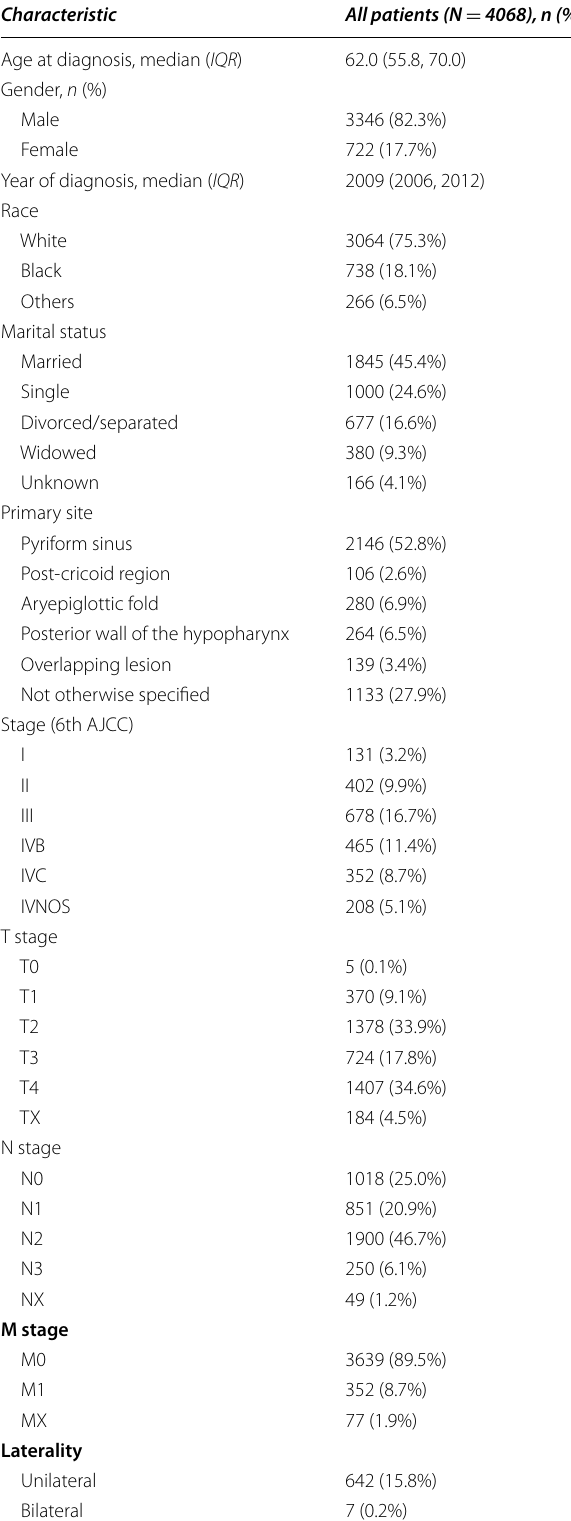
Table 1 Demographic, clinic pathologic, and therapeutic features of 4068 patients across all selected primary sites